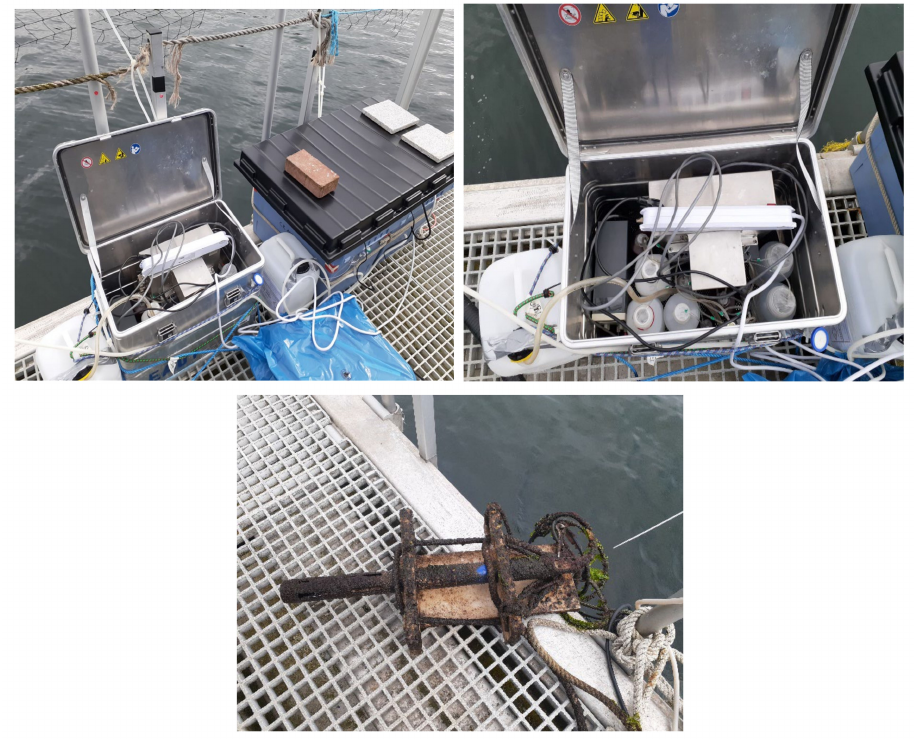
Figure 3. Deployment setup of the AutoLAB analyzer ( upper ) and the EXO2 Sonde after the deploy- ment ( bottom